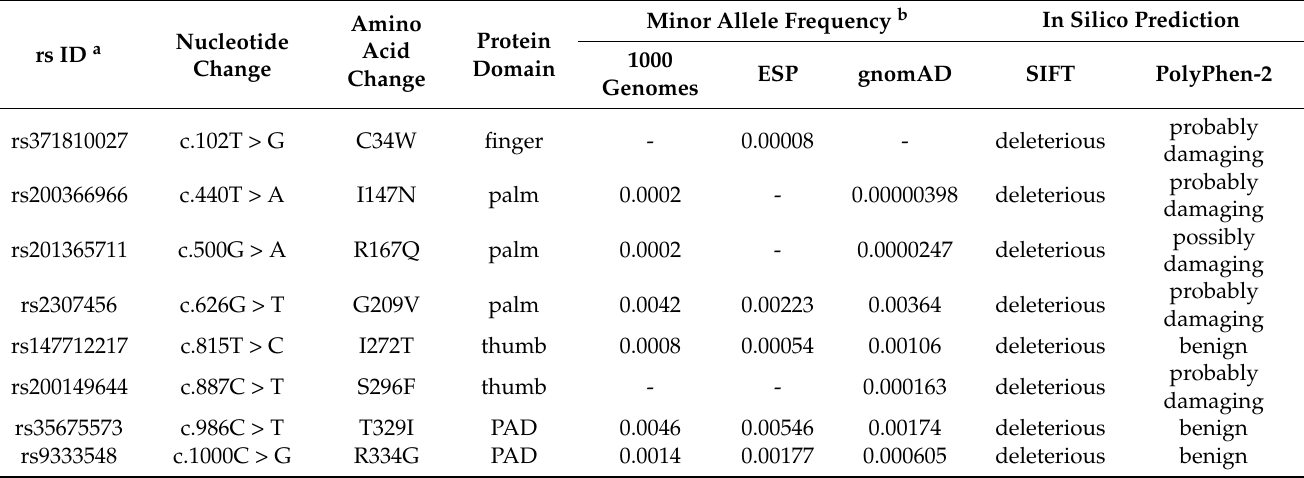
Table 1. Human germline POLH variants